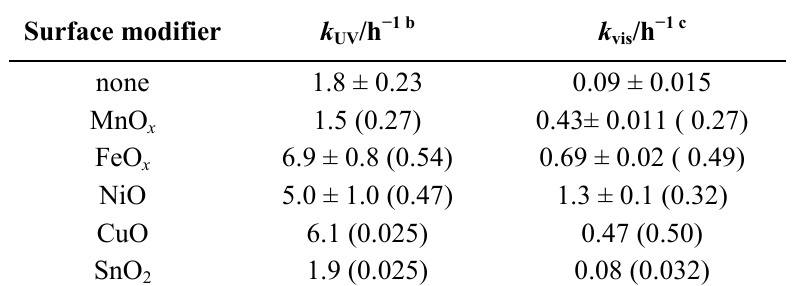
Table 1. Photocatalytic activities of metal oxide-surface modified TiO 2-naphthol degradation a